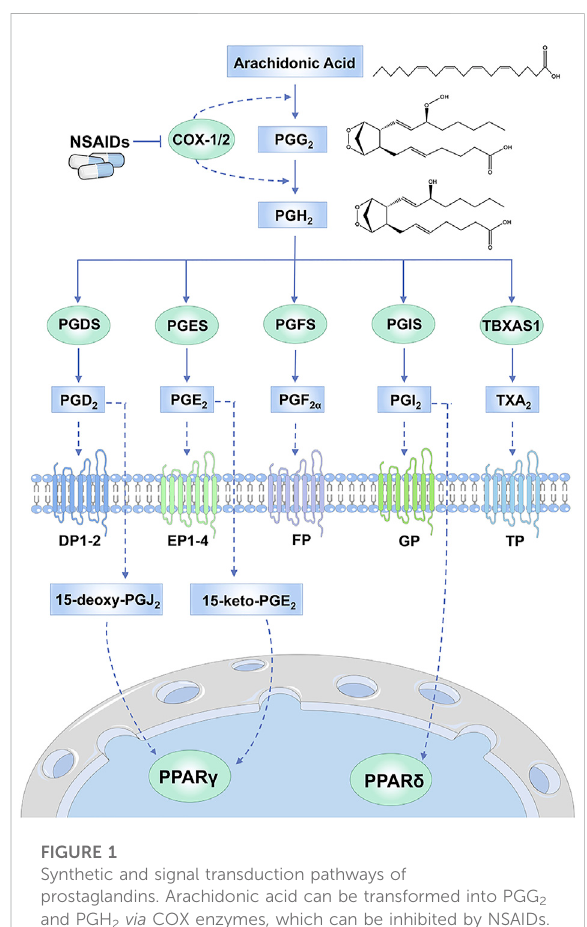
FIGURE 1 Synthetic and signal transduction pathways of prostaglandins. Arachidonic acid can be transformed into PGG 2 and PGH 2 via COX enzymes, which can be inhibited by NSAIDs. Then PGH 2 is converted into various prostaglandins via speci fi c synthases. Prostaglandins then exert their actions by activating receptors on cell membranes, including DP1-2, EP1-4, FP,IPandTP.NuclearreceptorssuchasPPAR γ andPPAR δ canalso be activated by prostaglandins or their metabolites. Abbreviations: PGG 2 , prostaglandin G 2 ; PGH 2 , prostaglandin H 2 ; PGDS, PGD synthase; PGES, PGE synthase; PGFS, PGF synthase; PGIS, PGI synthase; TBXAS1, TXA synthase; peroxisome proliferator- activated receptor